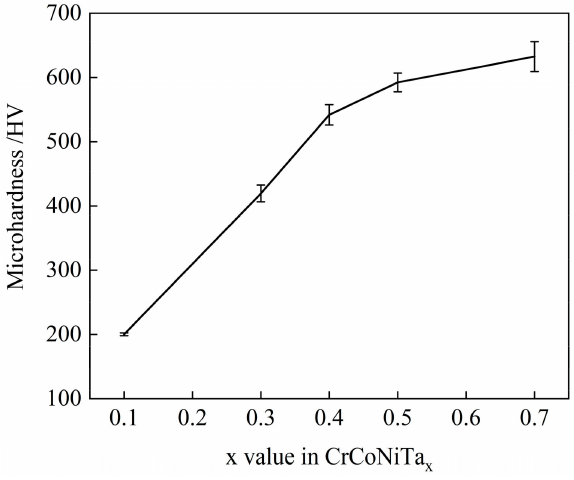
Figure 6. Hardness of CrCoNiTa x